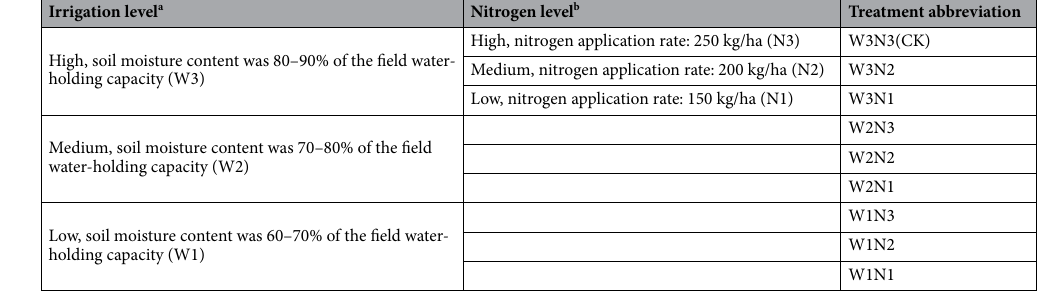
Table 2. Description of treatments. a High irrigation level treatment, in which the soil moisture content was 80–90% of the field water-holding capacity. In the medium irrigation level treatment, the soil moisture content was 70–80% of the field water-holding capacity. In the low irrigation level treatment, the soil moisture content was 60–70% of the field water-holding capacity. b High nitrogen level treatment, with a nitrogen application rate of 250 kg/ha. In the medium nitrogen level treatment, the nitrogen application rate was 200 kg/ha. In the low nitrogen level treatment, the nitrogen application rate was 150